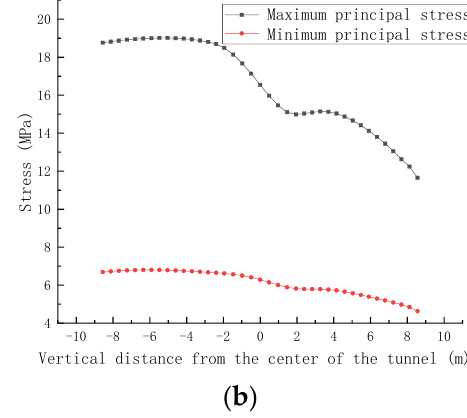
Figure 10. Changes in the principal stresses of the roadway’s surrounding rock when the roadway excavation leaves top coal bottom coal. ( a ) Horizontal direction. ( b ) Variation direction.